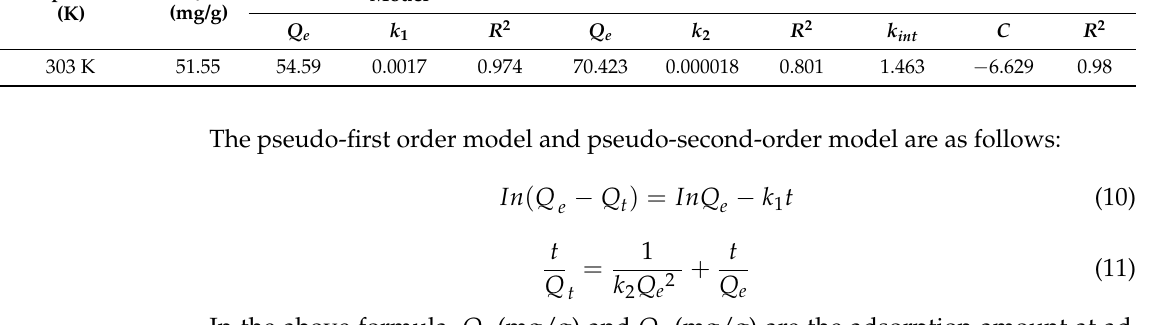
Table 3. Parameters of pseudo-first order, pseudo-second order and Weber–Morris model.